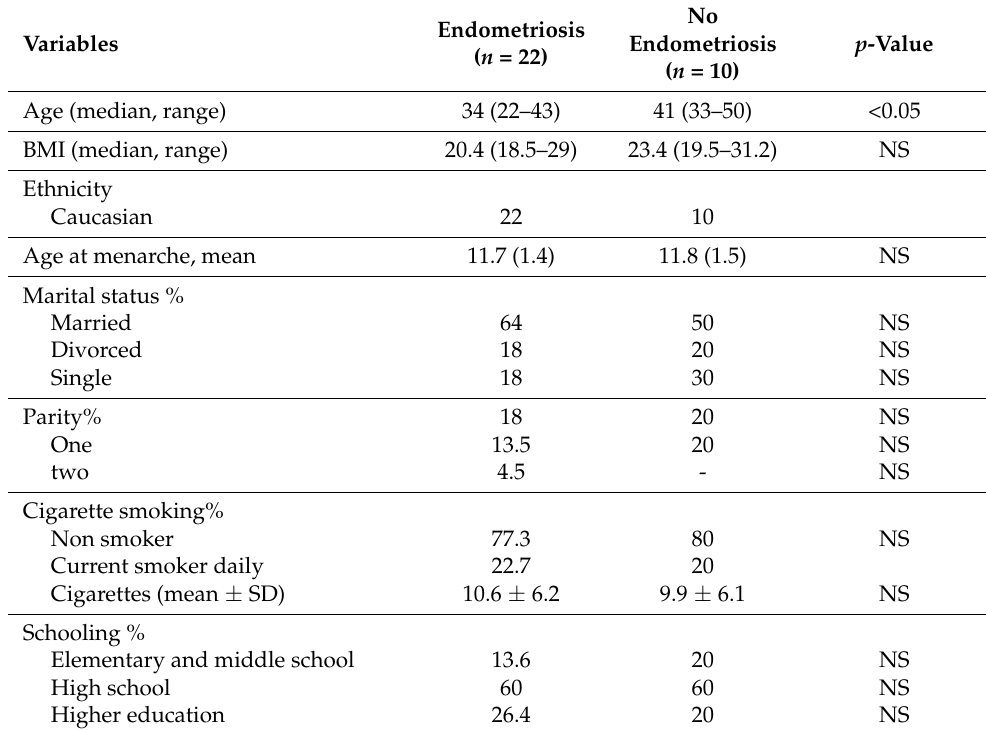
Table 2. Demographic data of the enrolled